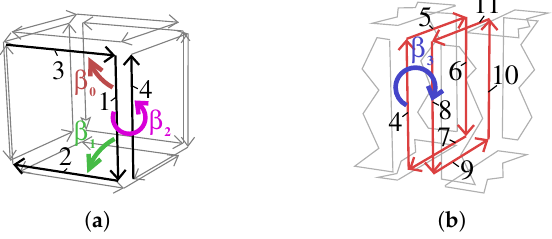
Figure 2. Two parts of the 3-map illustrated in Figure 1b, where some darts are numbered. ( a ) Cube representing V 0 . ( b ) Face between V 0 and V 1 .